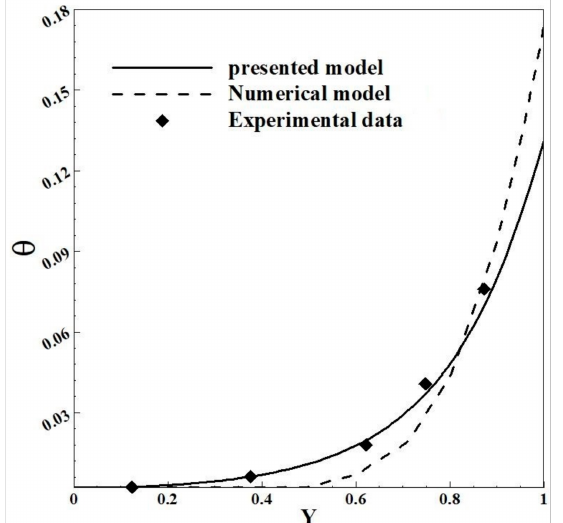
Figure 3. The comparison between the normalized temperature achieved from the present model and the numerical and experimental data [5] for air flow into an ERG aluminum porous foam at ε =